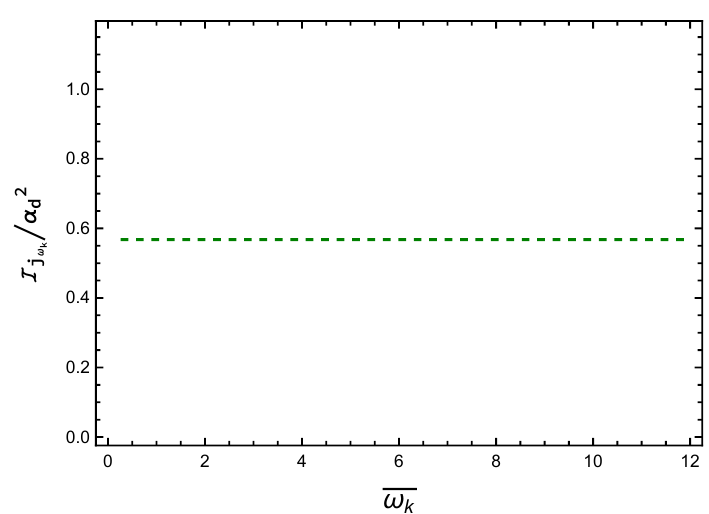
for fixed ∆ E = 0 . 5 k